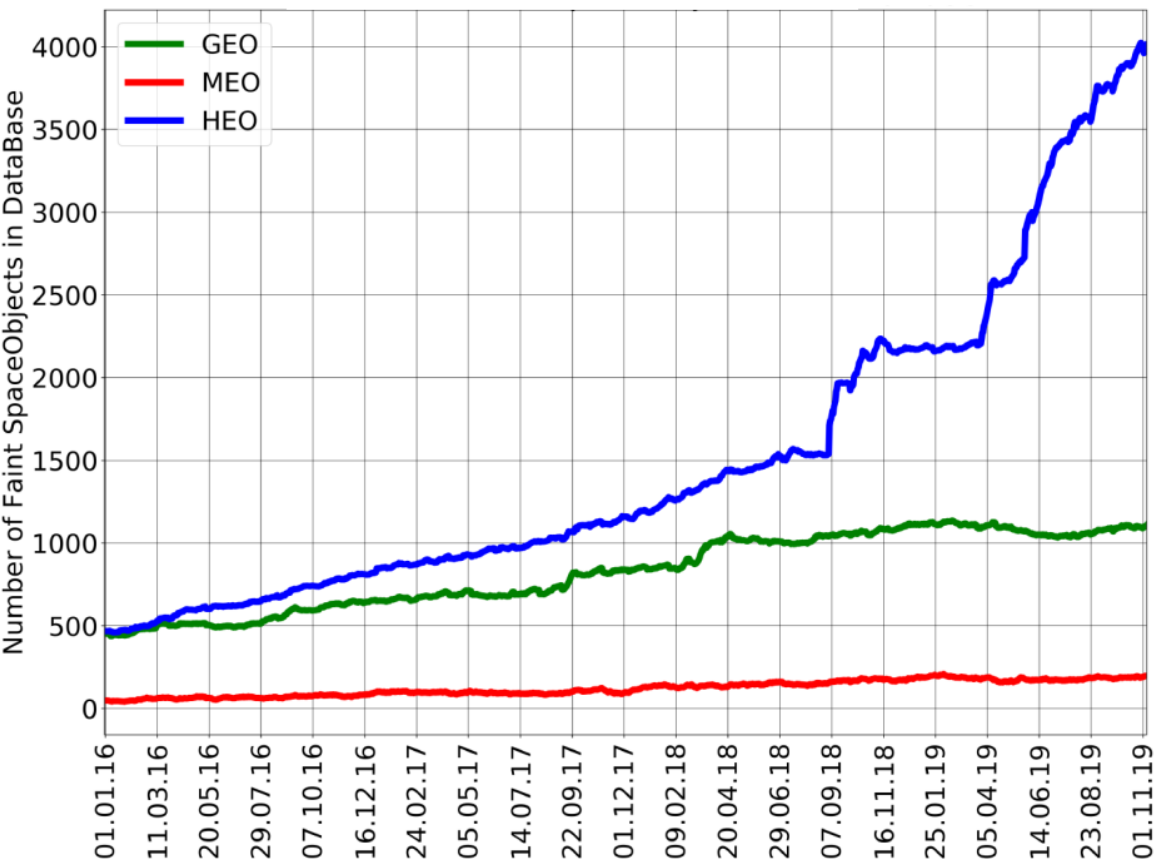
Figure 4. Number of the faint objects at high orbits yearly in the ISON database. This shows how the number of different types of faint objects in the catalog changes over time – GEO (green color), HEO (blue color), MEO (red color). Vertical axis - number of objects, horizontal –